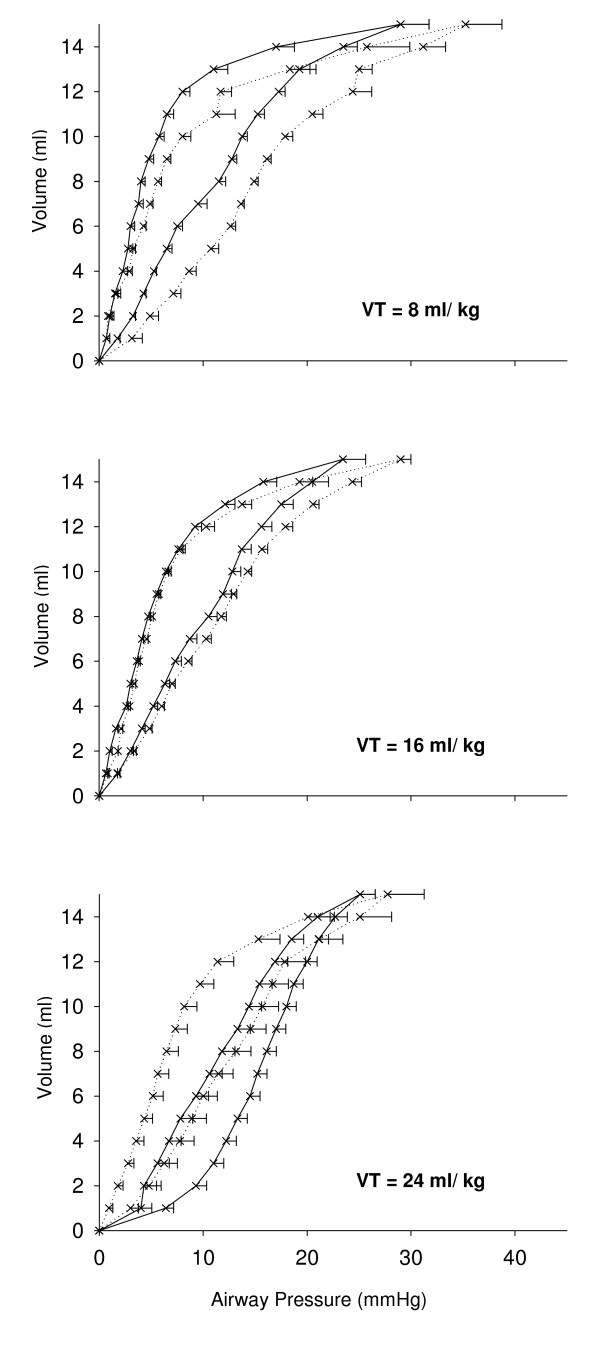
Respiratory system static pressure-volume curves in ventilated young (dotted lines) and old (solid lines) rats. Mechanical ventilation (MV) was applied for 4 hours with tidal volume (VT) of 8, 16 or 24 ml/kg body weight, respectively. The shift of the curves is significant in animals ventilated with VT 8 and 24 ml/kg body weight, respectively.